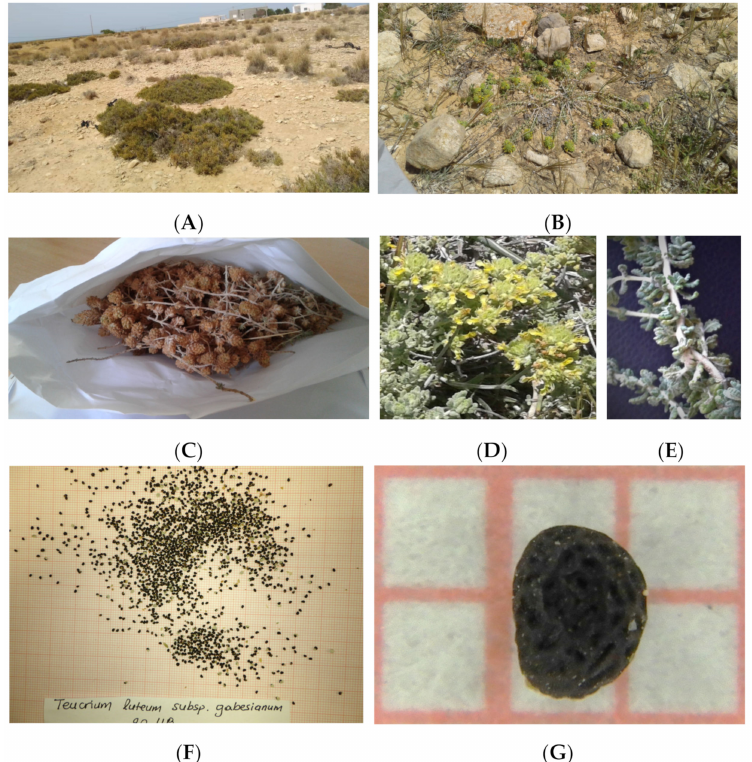
Figure 2. ( A ) Wild habitat; ( B ) Prostrate habit of a wild-growing individual; ( C ) Collected inflores- cences; ( D , E ) Inflorescences and leaves; ( F ) Extracted seeds and morphology of a ripe individual seed ( G ) of Teucrium luteum subsp. gabesianum